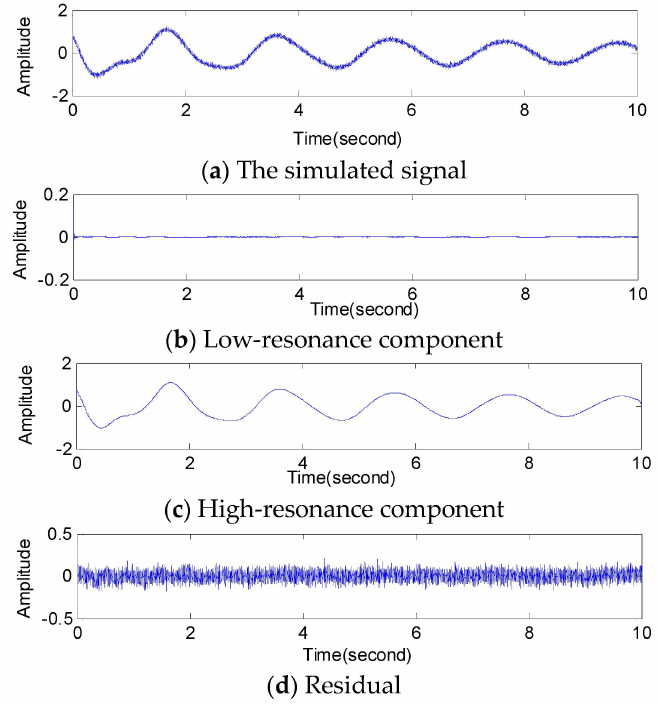
Figure 5. RSSD of the simulated signal with white Gaussian